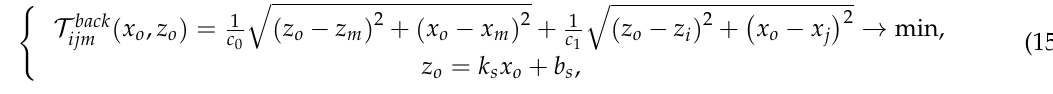
the total travel time is